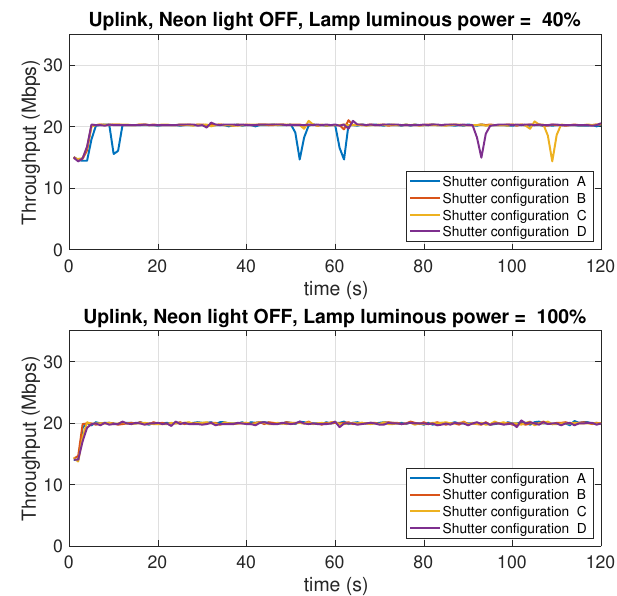
Figure 24. Uplink throughput with different shutter configurations (see Table 1). Neon lights OFF. LED lamp luminous power: 40% (top charts) and 100% (bottom charts) of the maximum value of